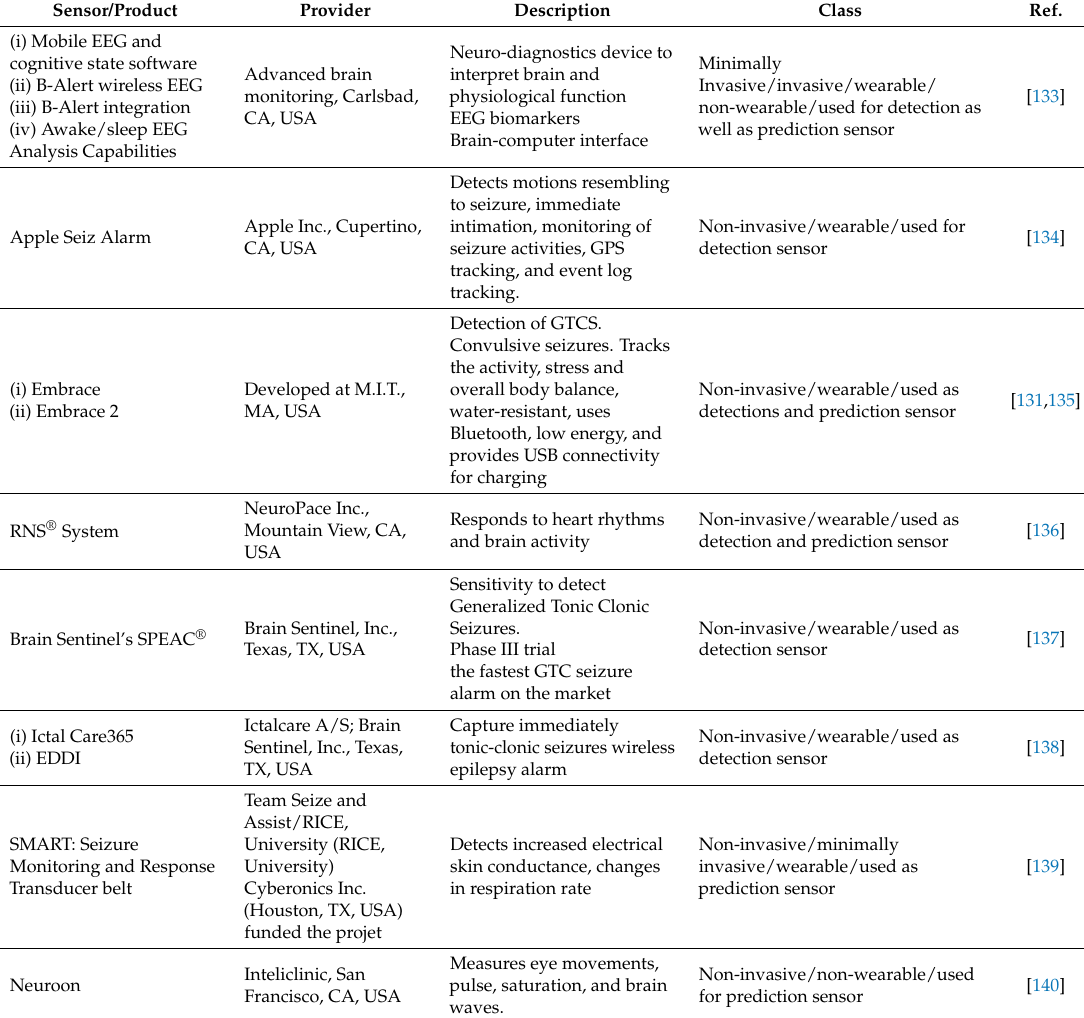
Table 3. Available sensing devices in the